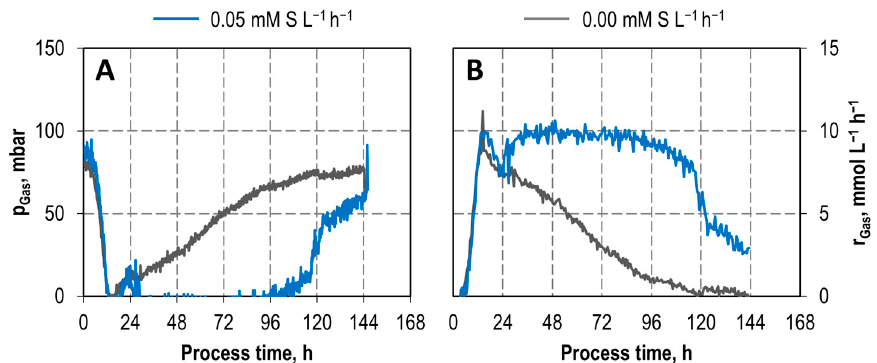
Figure 5. Partial pressures ( A ) and CO consumption rates ( B ) in stirred-tank reactors with C. carboxidivorans with sulfide feeding of 0.05 mM S L − 1 h − 1 (blue) and without sulfide feeding (grey) (T = 37 °C; pH = 6.0; P V − 1 = 10.5 W L − 1 ; F gas = 0.042 vvm (10:20:70 CO:CO 2 :N 2 )).